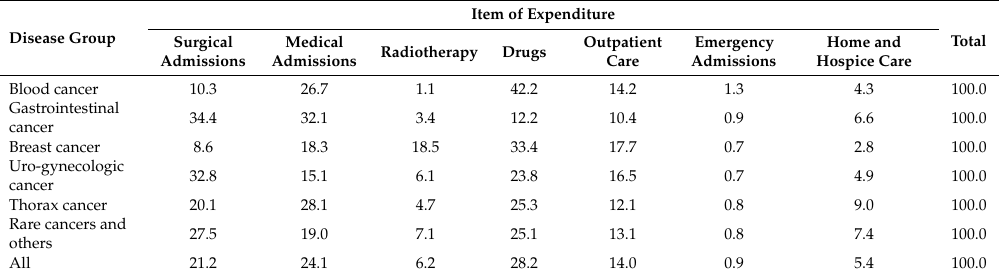
Table 2. Percent distribution of the total annual disease-group-specific cancer care cost by cost item (Province of Forl ì -Cesena, northern Italy, year 2016) a . Disease Group